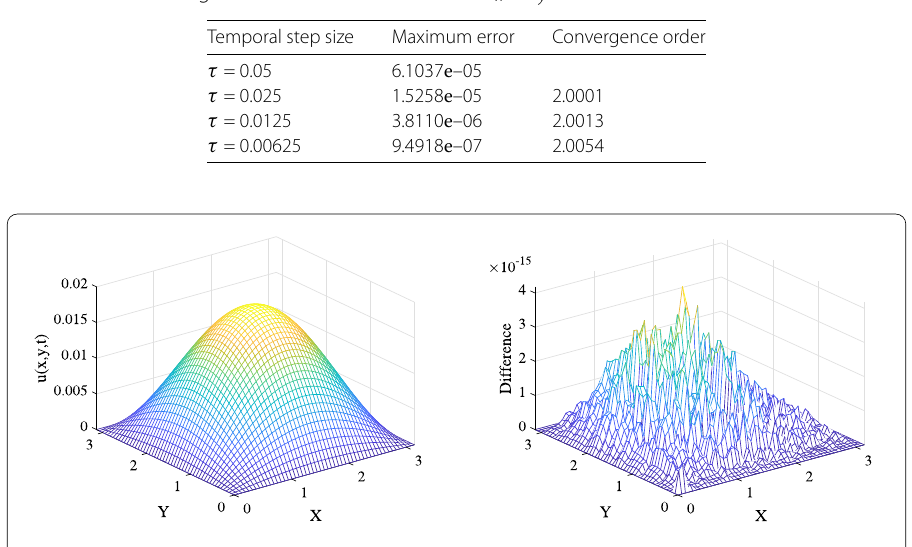
Table 12 The convergence order for R-ADI-CFDS4 at h x = h y = 0.02 π